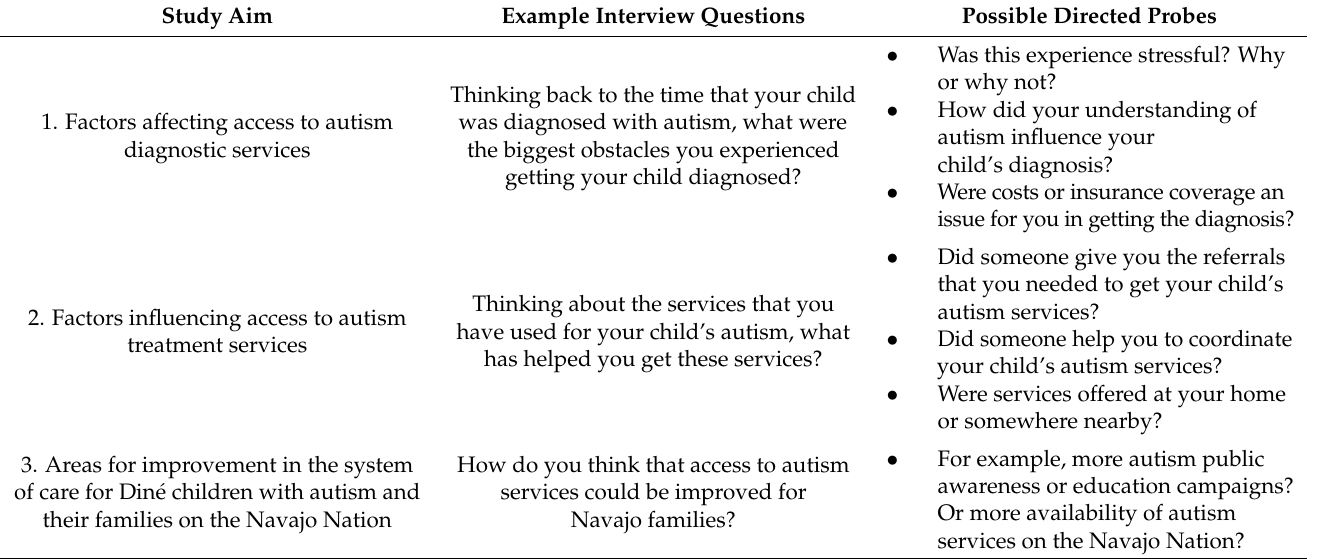
Table 2. Example Interview Questions and Directed Probes about Din é Parents’ Lived Experiences Raising a Child with Autism, by Study